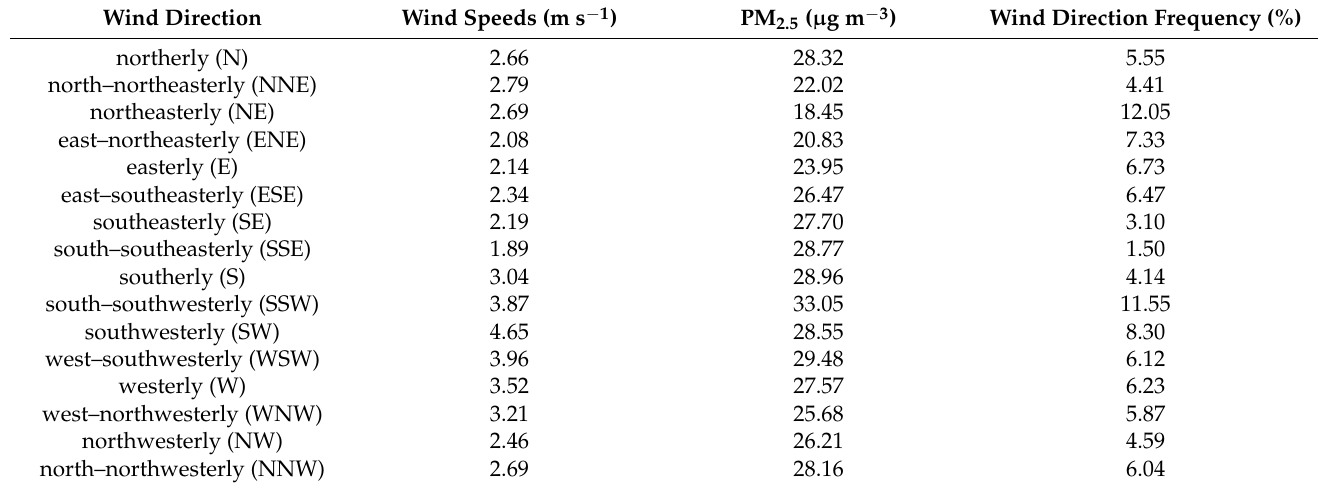
Table 2. Average wind speed (ASOS 159) and PM 2.5 concentration (AQMS 221112) for each wind direction. Wind speeds (2011–2020) and PM 2.5 concentrations (2015–2020) are averages over school hours (07 LST to 18 LST). Wind Direction Wind Speeds (m s − 1